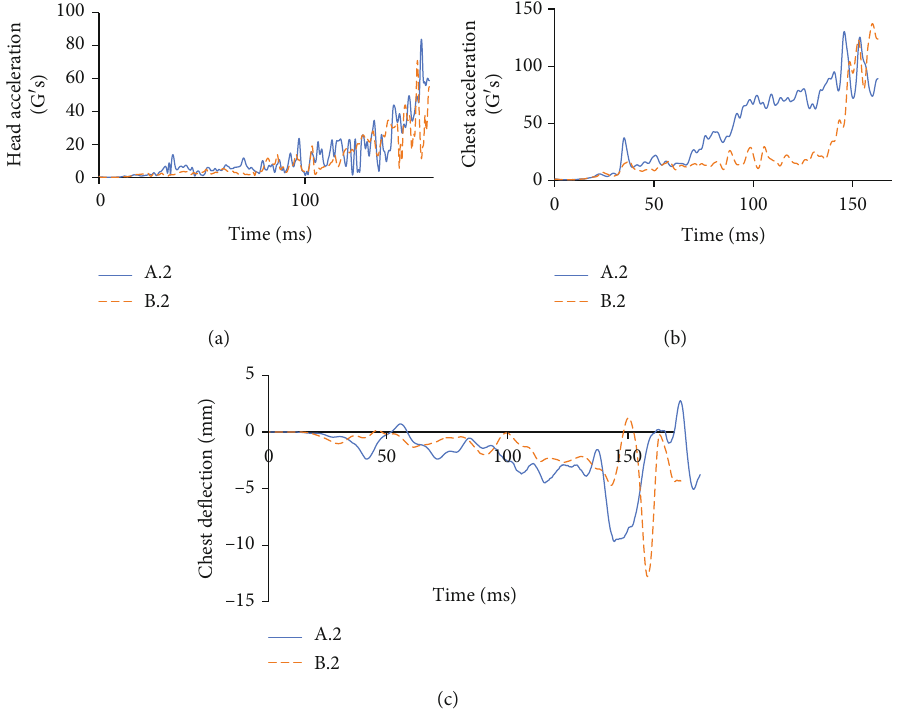
Figure 10: (a) Acceleration of head gravity center and HIC at a speed of 50 km/h. (b) Acceleration of chest gravity center in G ’ s at a speed of 50km/h. (c) Chest de fl ection in mm during the accident at a speed of 50